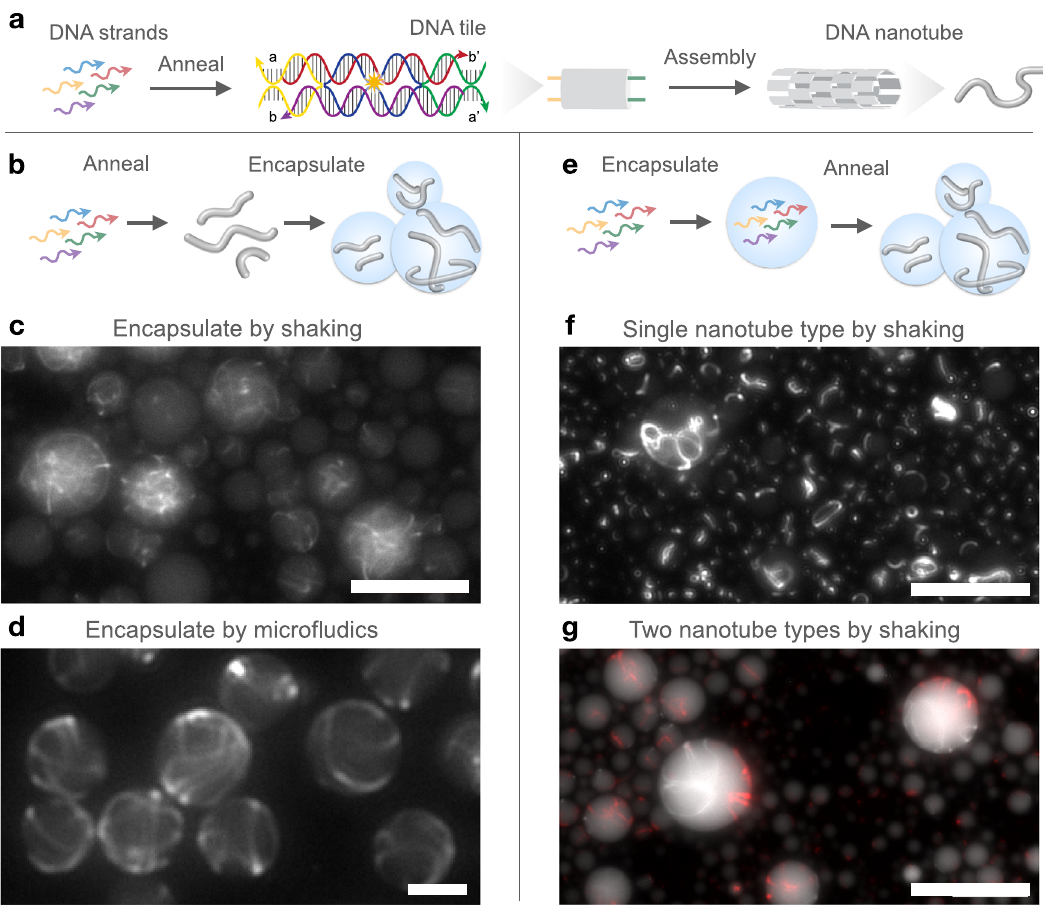
Fig. 1 Schematic of DNA tiles and nanotubes and different methods for encapsulating and assembling DNA nanotubes in water-in-oil droplets. a DNA tiles composed of fi ve unique ssDNA oligomers (shown in blue, red, yellow, green, and purple strands) that self-assemble into DNA nanotubes. Assembly occurs via hybridization of single-stranded complementary domains known as sticky-ends (marked as a, complementary to a ′ , and b complementary b ′ ). Tiles are labeled with a fl uorescent molecule, indicated here by the yellow star, for easy observation of DNA nanotubes under fl uorescence microscopy. b DNA nanotubes can be pre-annealed from constituent oligomers in vitro before encapsulation in water-in-oil droplets. Representative fl uorescence microscopy images of pre-annealed DNA nanotubes inside droplets using two different encapsulation protocols. c Nanotubes encapsulated via the shaken protocol at room temperature. Tile concentration is 500 nM. d Nanotubes encapsulated via the micro fl uidic protocol at room temperature. Tile concentration is 350 nM. e Constituent oligomers can be encapsulated inside the droplets and later annealed to form nanotubes. Multiple species of nanotubes can be simultaneously annealed in the droplets if the required strands are present in the initial encapsulated solution. f Representative fl uorescence microscopy image of a single nanotube species annealed inside droplets (250 nM tile concentration) and then imaged at room temperature. g Example fl uorescence image of two distinct species of DNA nanotubes annealed inside droplets (250 nM each tile), labeled with Cy3 dye (white) and Atto647N dye (red), respectively and then imaged at room temperature. Scale bars: 30 μ